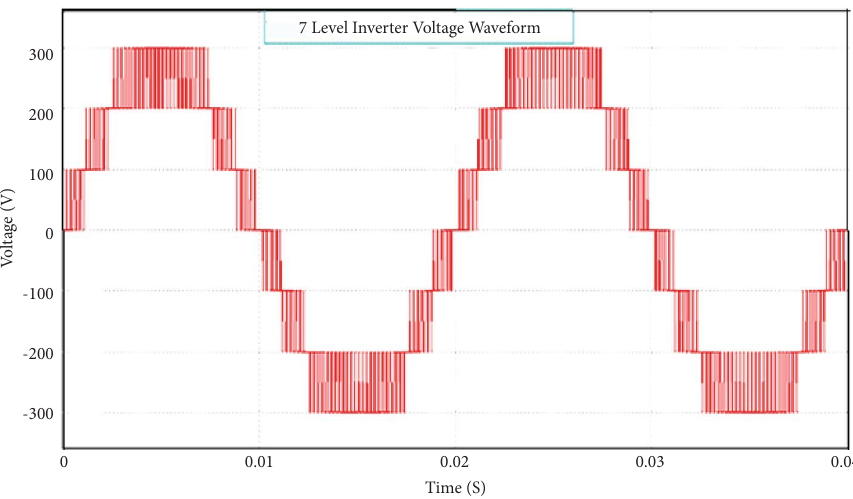
Figure 6: Te output voltage waveform of a single-phase seven-level